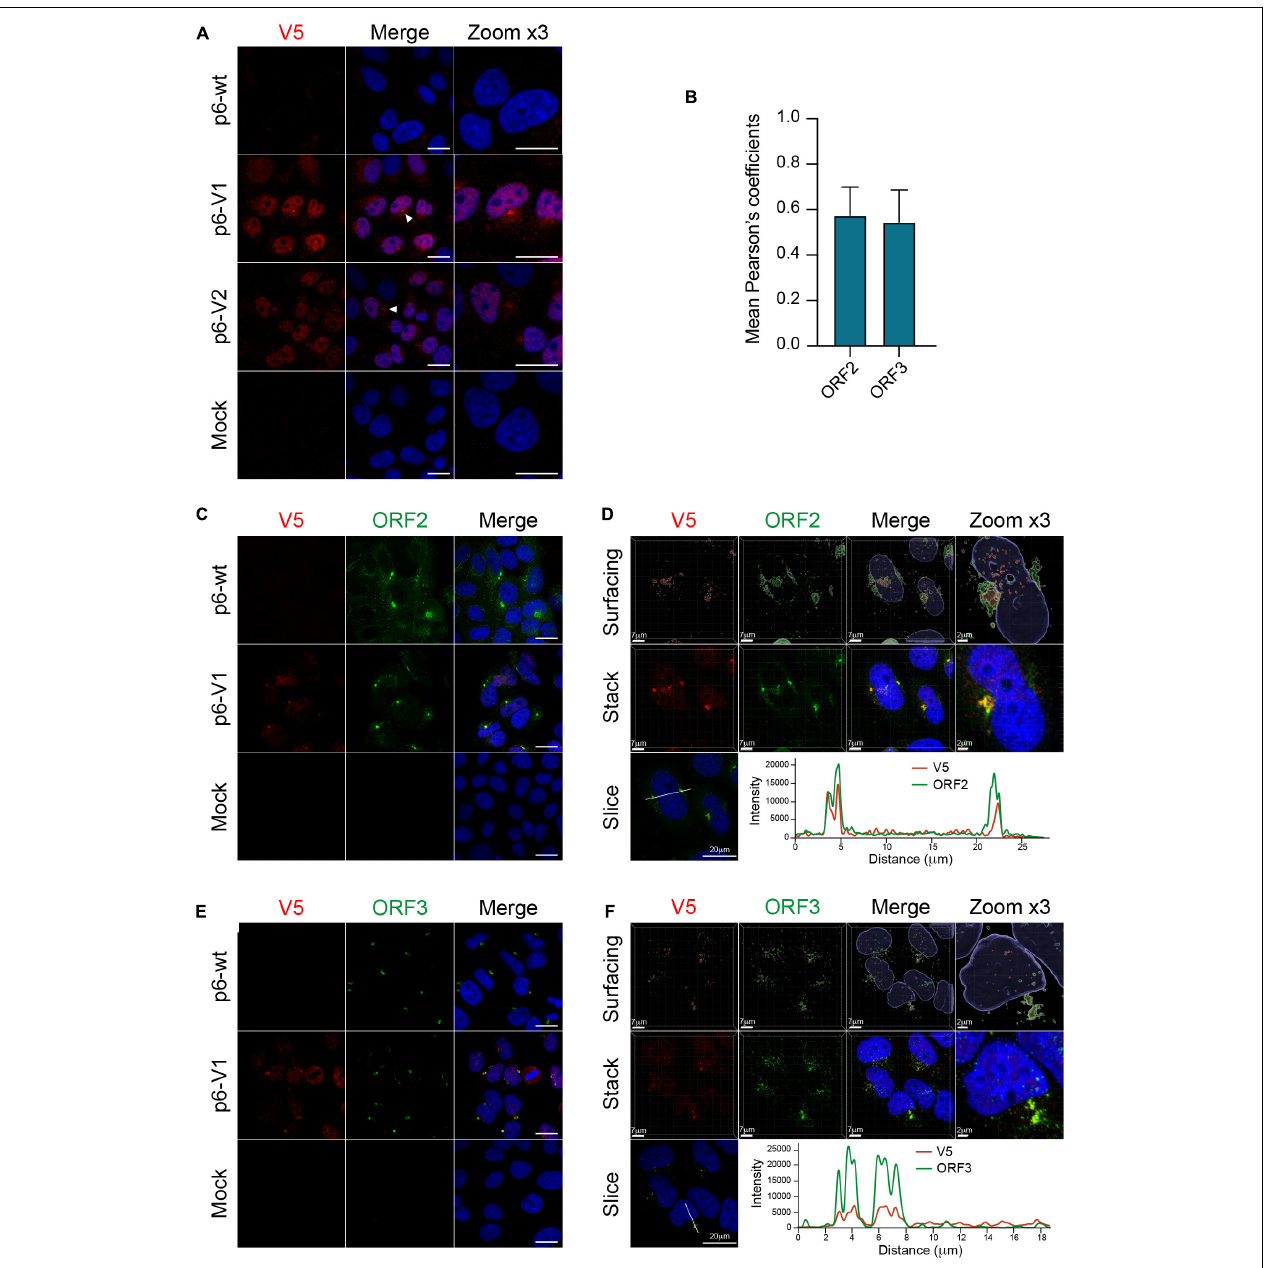
FIGURE 7 | Co-localization of the V5-tagged ORF1 and ORF2/ORF3 proteins in the host cell. (A) PLC3 cells were electroporated with the p6 strain expressing either the untagged (p6-wt) or the V5-tagged ORF1 (p6-V1, p6-V2) proteins. Three dpe, cells were processed for immunofluorescence using an anti-V5 antibody (red) prior to analysis by confocal microscopy. Perinuclear nugget-like structures are shown (white arrowheads). The cell nuclei were stained with DAPI (blue). Mock-electroporated cells served as negative control. Scale bar = 20 µ m. (B) Regions of interest (ROI) were drawn around the perinuclear nugget-like structures on images taken from PLC3 cells electroporated with p6-V1 and co-labeled with antibodies directed against the V5 epitope and the ORF2 (C) or the ORF3 proteins (E) . ROI were used to determine Pearson’s correlation coefficients (PCC) between V5-tagged ORF1 and ORF2 (ORF2) labeling or V5-tagged ORF1 and ORF3 (ORF3) labeling using JACoP plugin from ImageJ software. PCC means ( ± standard deviation) were calculated from 30 different ROI. (C–E) Co-labeling of the V5-tagged HEV ORF1 replicase with ORF2/ORF3 in PLC3 cells. PLC3 cells were electroporated with p6-wt or p6-V1. Three dpe, viral proteins were co-labeled with antibodies directed against the V5 epitope (red, V5) and (i) ORF2 [1E6, green, (C) ] or (ii) ORF3 [green, (E) ] prior to analysis by confocal microscopy. Mock-electroporated cells served as negative control. Antibodies used are listed in Table 2 . Scale bar = 20 µ m. (D–F) PLC3 cells electroporated with p6-V1 and co-stained with anti-V5 and (i) anti-ORF2 (D) or (ii) anti-ORF3 antibodies (F) were analyzed by confocal microscopy with a high resolution Airyscan module. On the top, volume rendering of the 3D z-stacks (Surfacing) using the Imaris software are shown to visualize the V5-tagged ORF1/ORF2 (D) or ORF1/ORF3 (F) substructures. In the middle, z-stacks are shown. On the bottom, line graphs show the fluorescence intensities of V5-tagged ORF1 and ORF2 or ORF3 staining measured every 50 nm across the region of interest highlighted by the white line in the micrograph shown on the left. Scale bars show the indicated length.